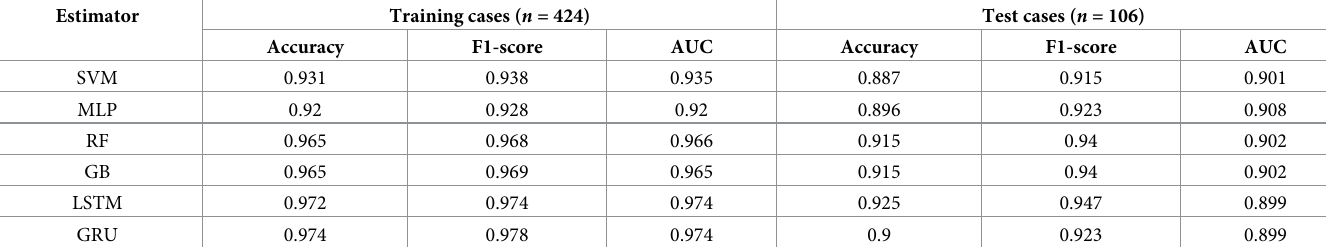
Table 1. Performance of train and test data for predicting weekly norovirus warning, using the 6 machine learning algorithms.